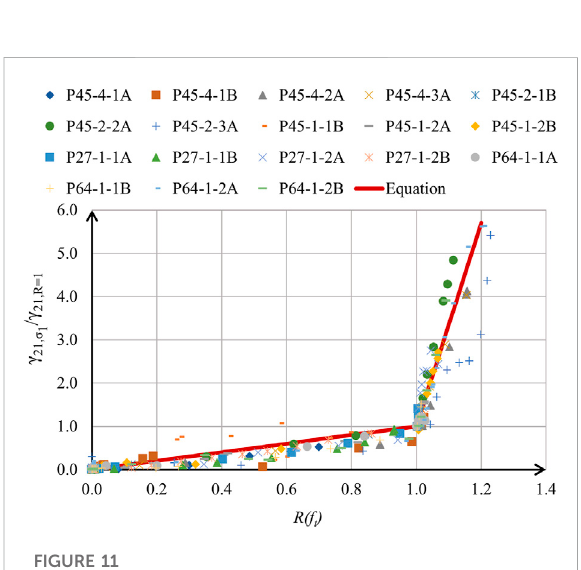
FIGURE 10 Normalised shear strain versus normalised compressive stress.